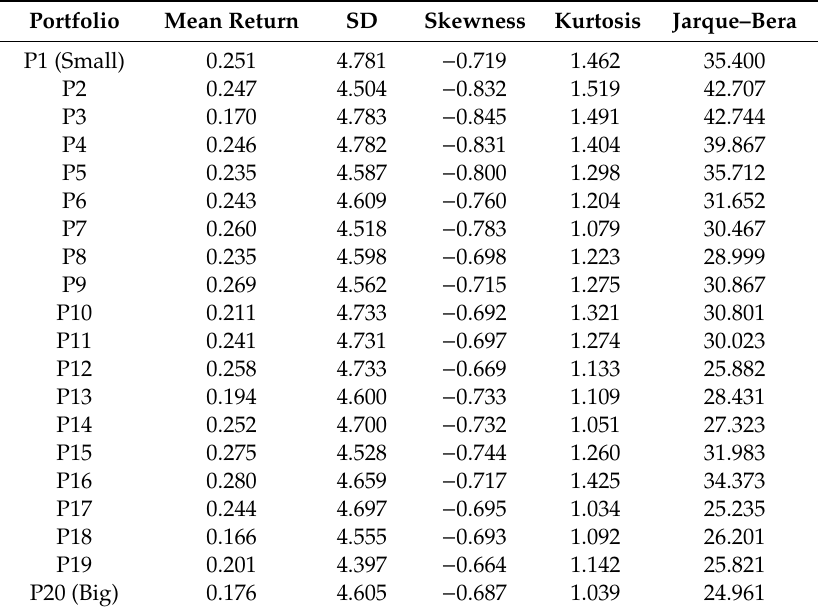
Table 4. Summary statistics for the portfolios under consideration 1 .